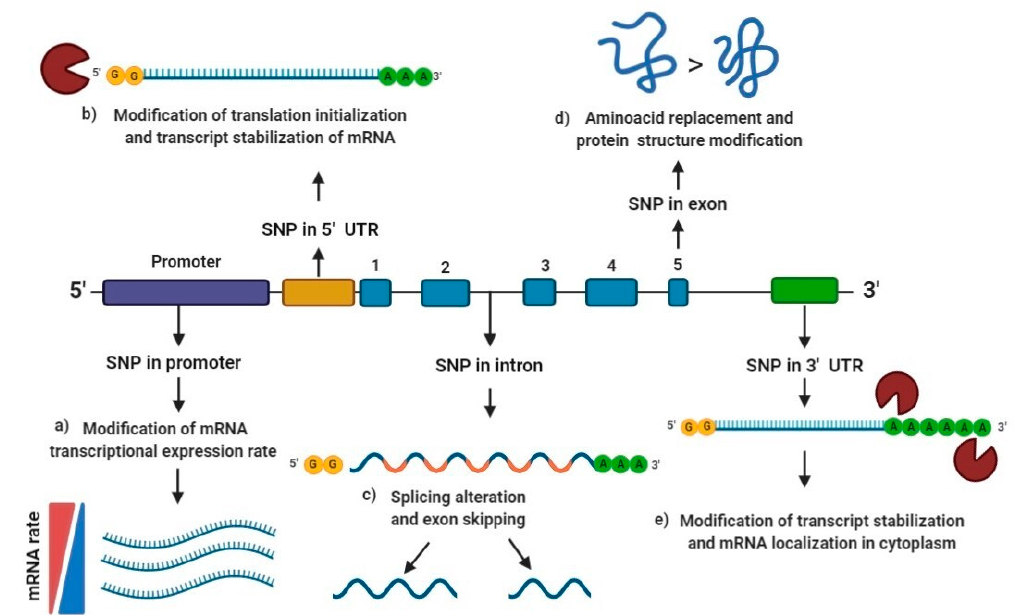
Figure 1. Functional e ff ect of single nucleotide polymorphisms (SNPs) according to their